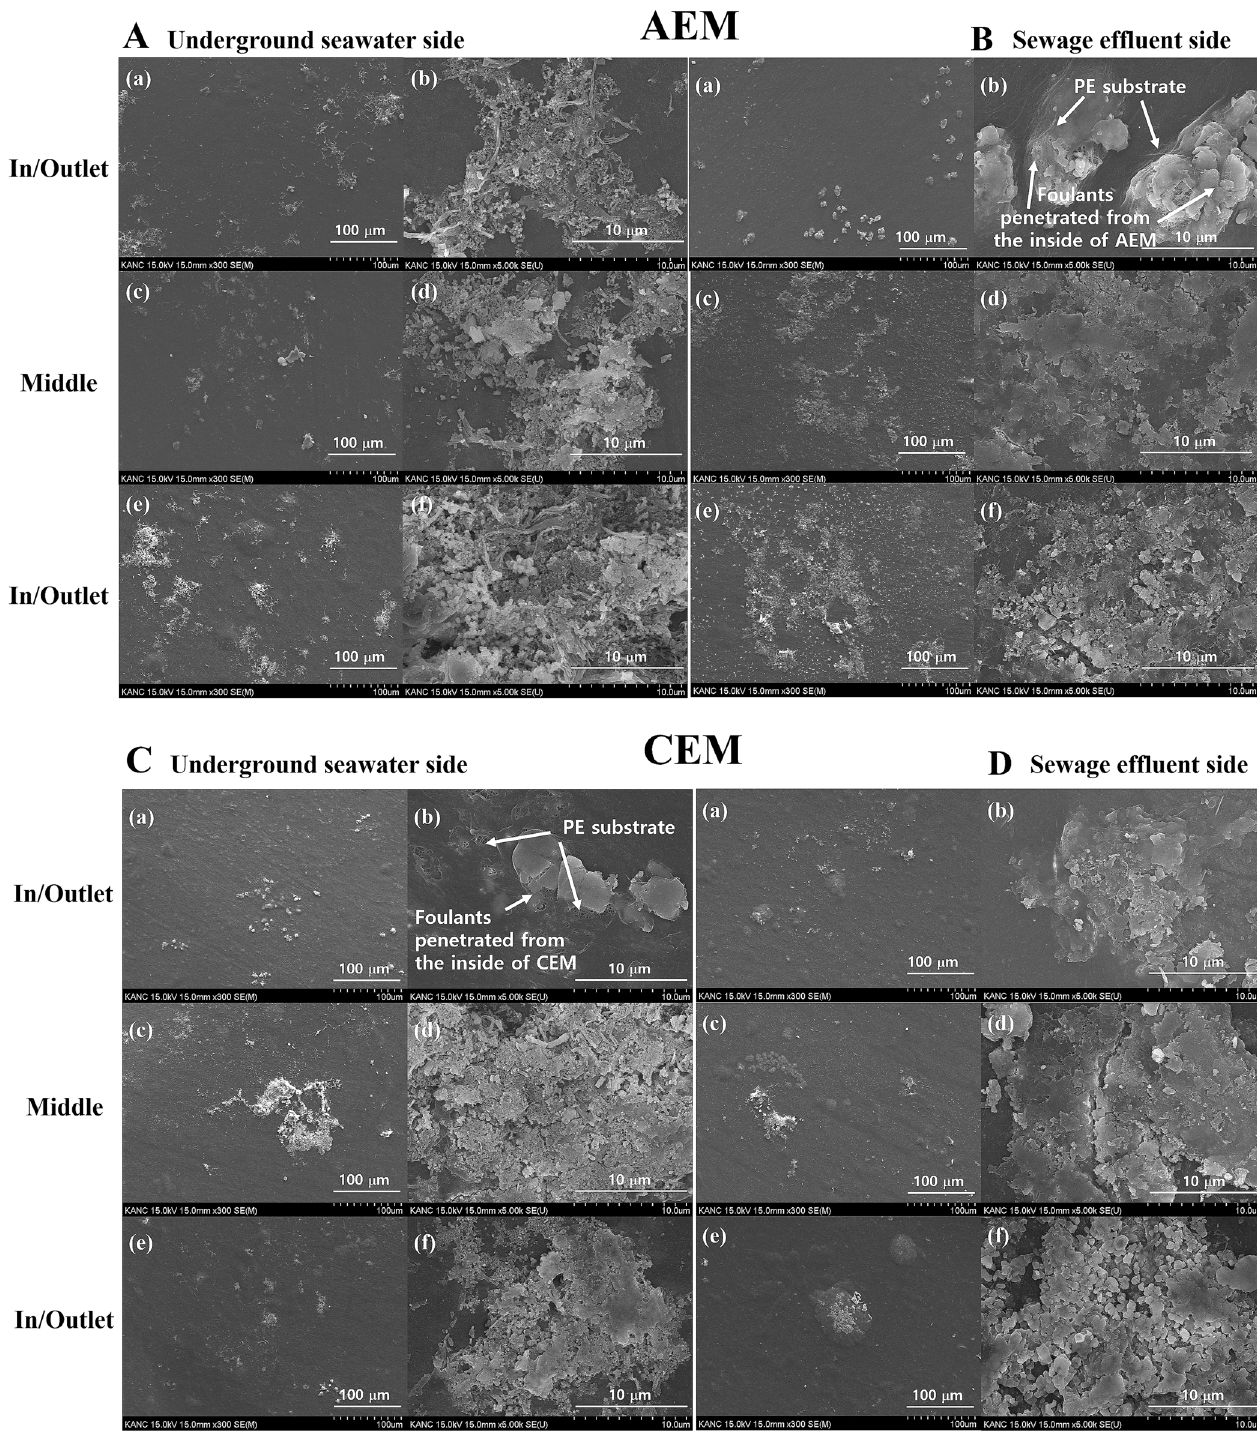
Fig. 6 FE-SEM images of patterned membranes after continuous RED operation for 5 days. A , B Show FE-SEM images of AEM at the underground seawater side and at the sewage ef fl uent side. C, D Show FE-SEM images of CEM at the underground seawater side and at the sewage ef fl uent side. Image magni fi cations: (a), (c), and (e) 300×; (b), (d), and (f) membranes. The AFM images in Supplementary Fig. 5 show pore- fi lling membranes used in this study consisted of densely extremely small spherical deposits in several places, unlike the packed polyelectrolytes in porous polyole fi n with pore sizes of images of the pristine AEM and CEM (Supplementary Fig. 6). In 60 nm, aquatic colloidal solids under 1 μ m can still be trapped contrast, the membrane surfaces of the patterned AEMs and CEMs inside or on the membranes. Moreover, this can become a form of (Fig. 6) showed less fouling along the pattern channel (Fig. 4). precipitation, whose occurrence can be attributed to ionic species Interestingly, for patterned membranes, the images showed the with charges that have polarity that is opposite those on the